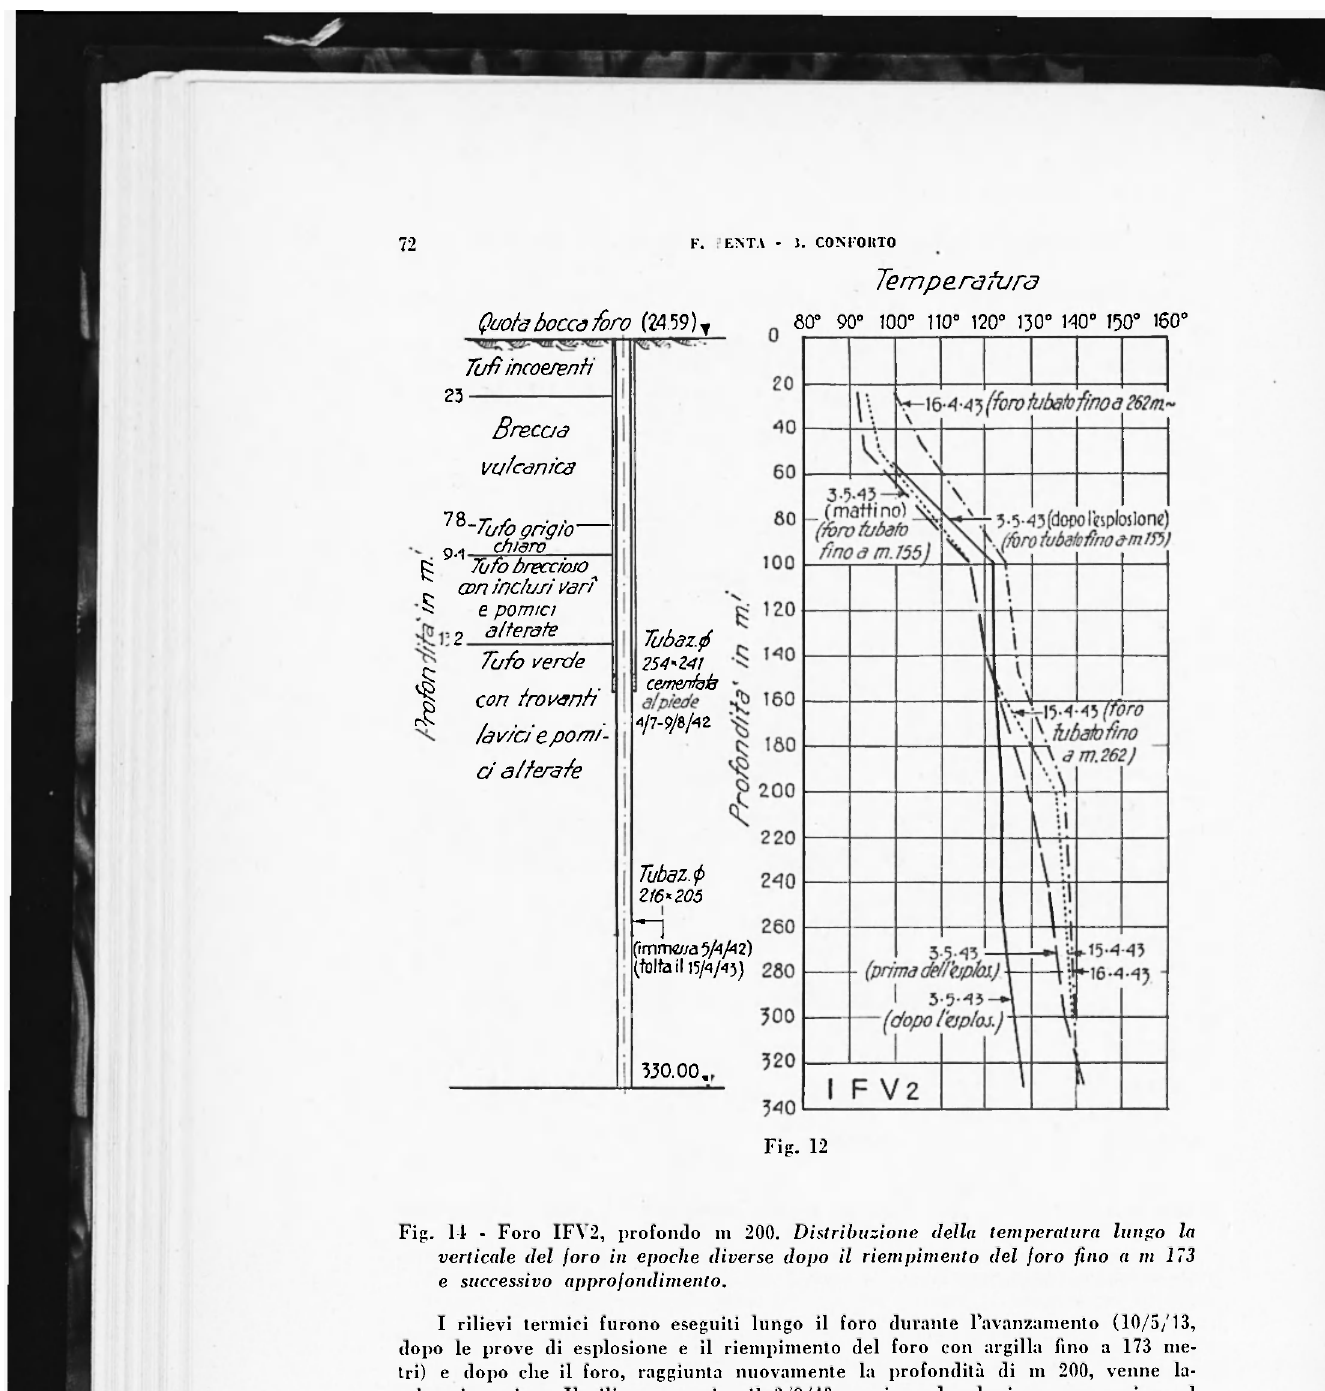
Fig. l-l - Foro IFY2, profondo m 200. Distribuzione della temperatura lungo la verticale del foro in epoche diverse dopo il riempimento del foro fino a m 173 e successivo